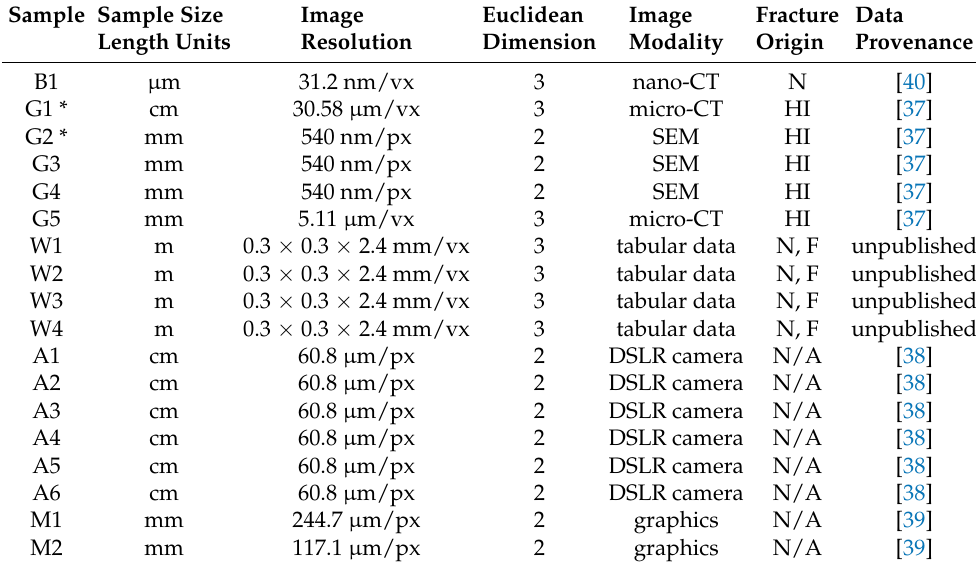
Table 1. Image data